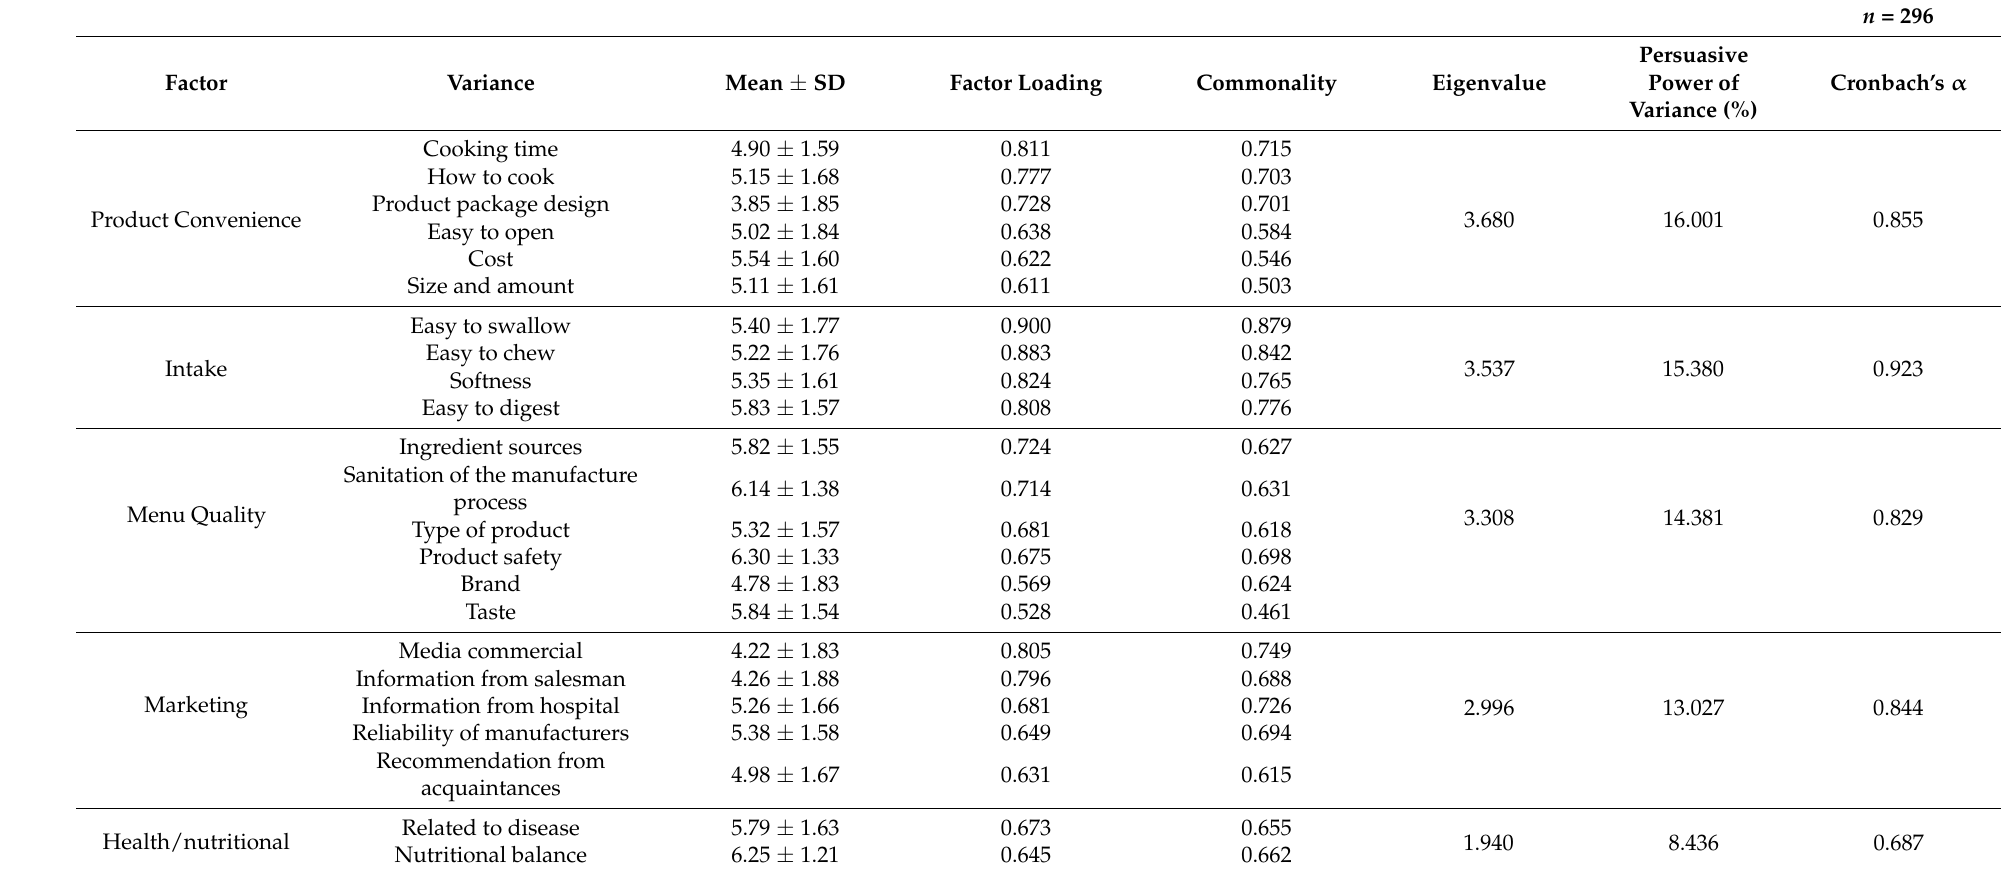
Table 3. Factor analysis of the selection attributes when purchasing food products.